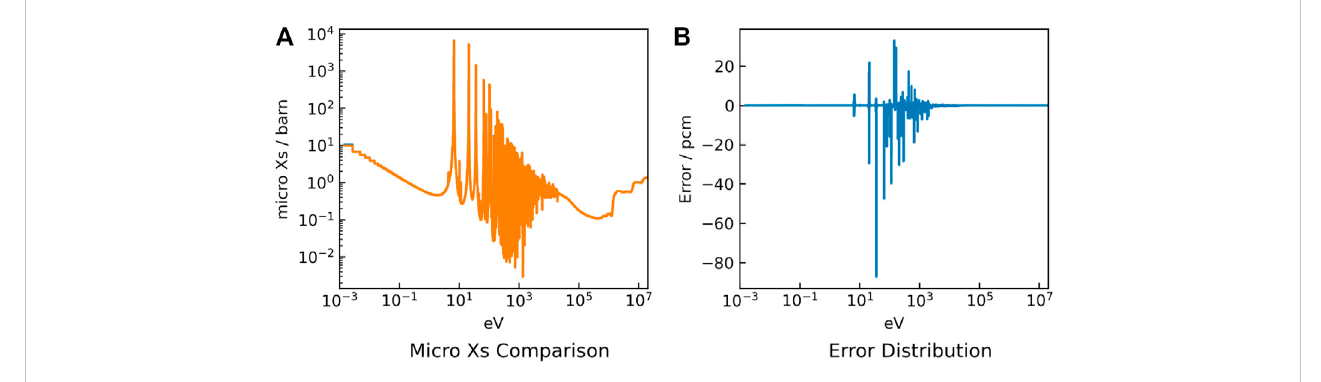
FIGURE 8 238 U absorption cross section results (A) and errors (B) for the intermediate spectrum